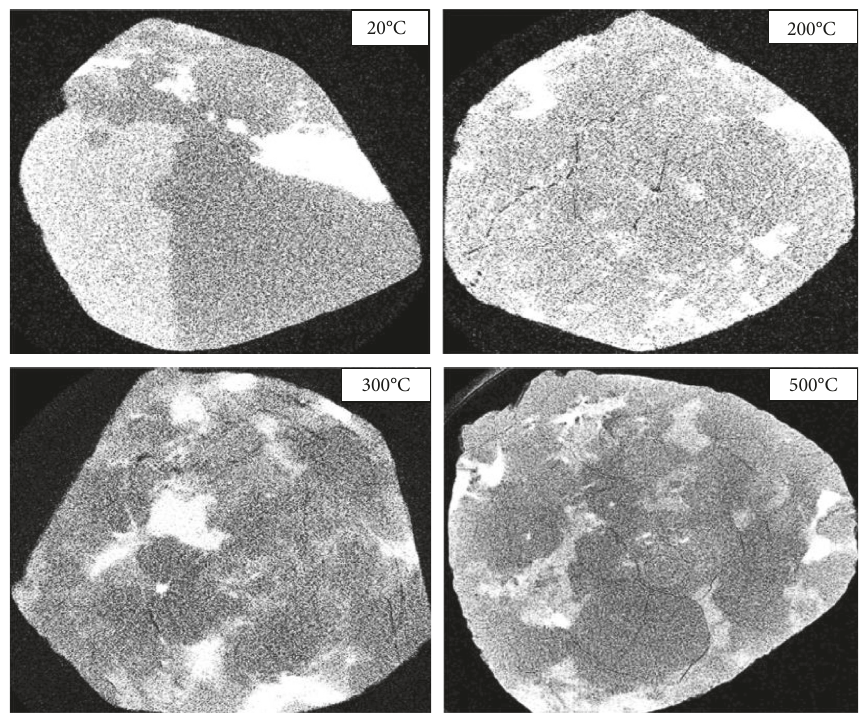
Figure 6: Effect of high temperature on the mesostructure of Lu gray granite (Zhao et